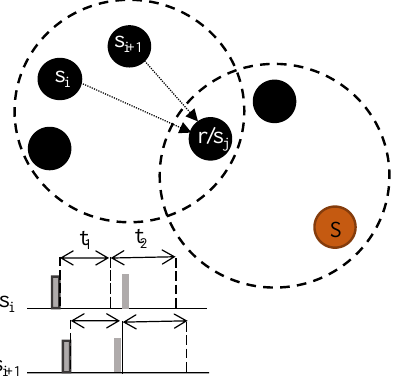
Figure 4. Wake-up reception in two neighboring nodes.